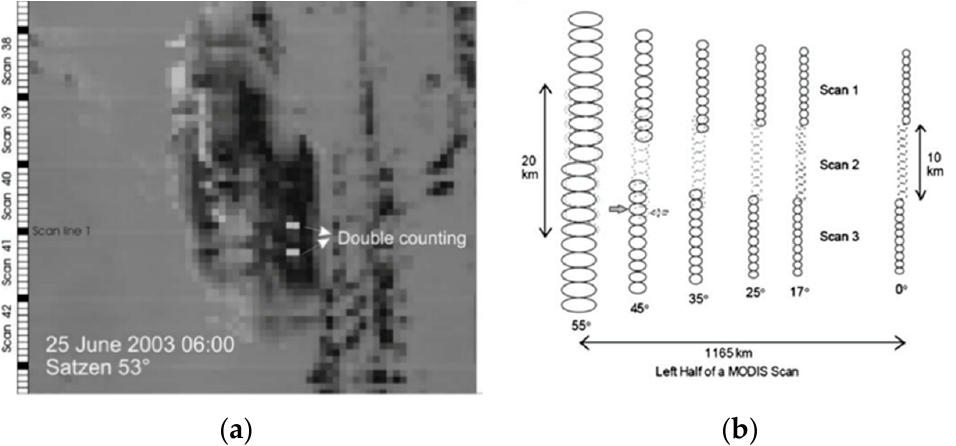
Figure 11. Figure from Coppola et al. (2010) [44]. ( a ) Bow-tie effect on the MODIS image of Piton de la Fournaise, acquired on 25 June 2003. We can see two pairs of pixels detected as hot spots resulting in ( b ) two scan lines from the same surface, thus resulting in double counting at a scan angle of about 45°.